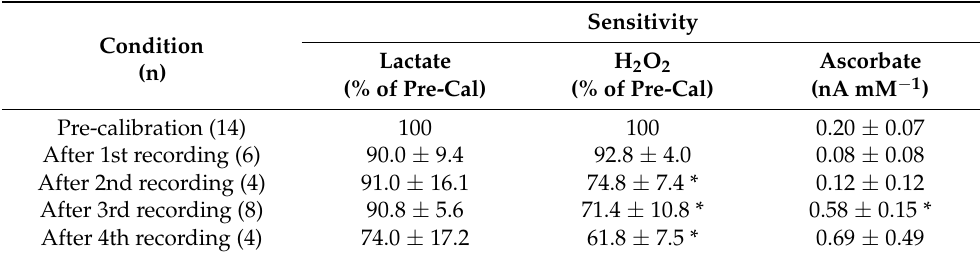
Table 2. Analytical parameters of CFM/Pt-LOx-PU-PD before (pre-calibration) and after each successive recording session in slices are shown as a percentage of the pre-calibration values or in nA mM − 1 (ascorbate sensitivity). Values represent mean ± SEM. * p < 0.05, for comparison to pre-calibration